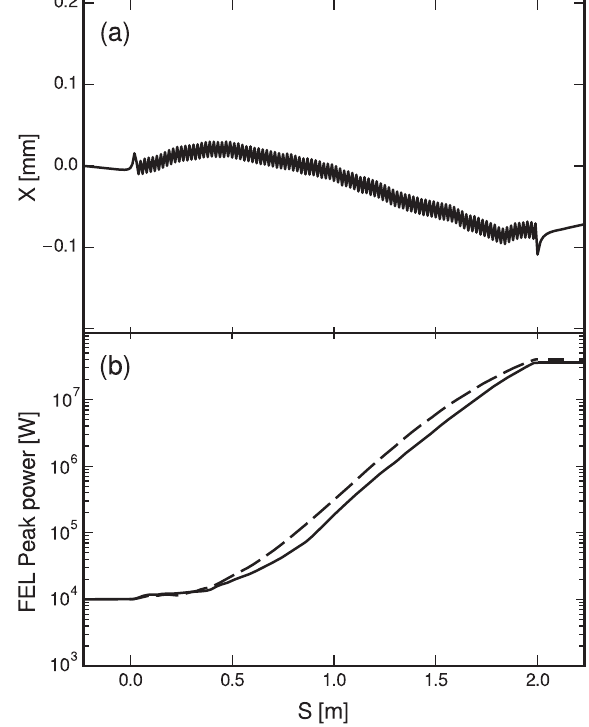
FIG. 16. (a) Electron beam trajectory in the horizontal plane using measured undulator magnetic field and (b) FEL power along the undulator using (line) measured and (dashed line) purely sinusoidal undulator magnetic field. Beam transport in the nonlinear case with OCELOT using the S2I-CM optics with r 11 ¼ r 33 ¼ 10 and r 56 ¼ 0 . 4 mm. FEL simulation with CHIMERA.